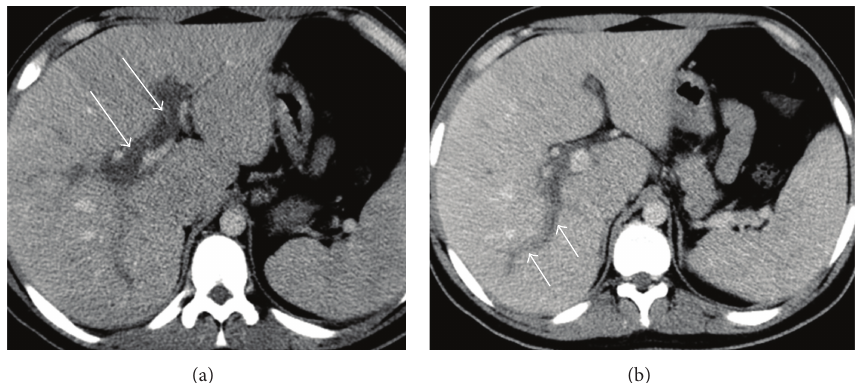
Figure 3: Axial contrast-enhanced CT images obtained through the midportion of the liver show thrombosis of the main portal branches (a) extending to the portal branch to the posterior segments of the right